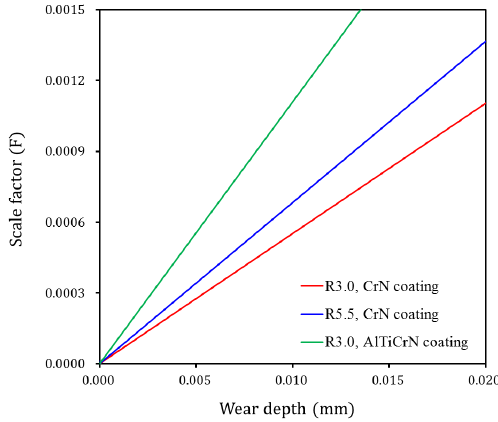
Figure 11. Scale factors for each punch condition.